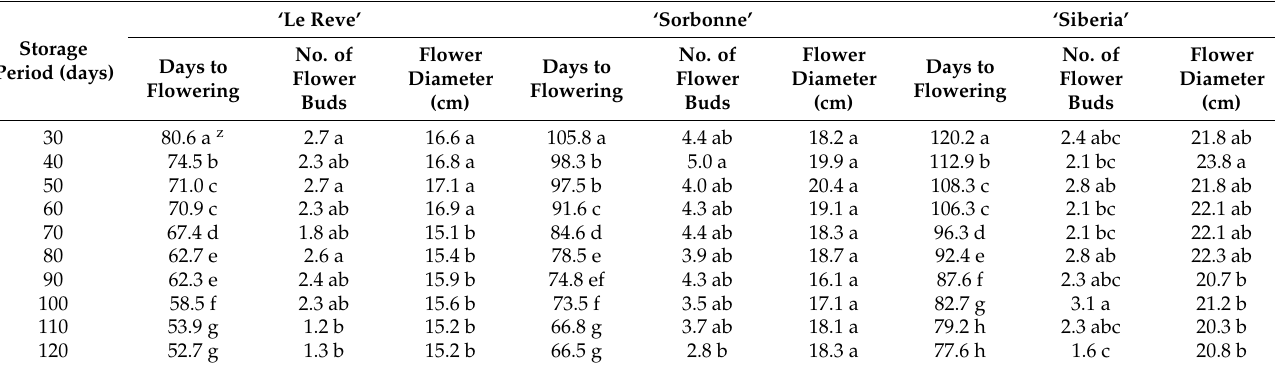
Table 2. Days to flowering, flower bud number, and flower diameter of cut flowers as influenced by bulb storage period at 0 ◦ C in Lilium Oriental Hybrids ‘Le Reve’, ‘Sorbonne’, and ‘Siberia’. Storage Period